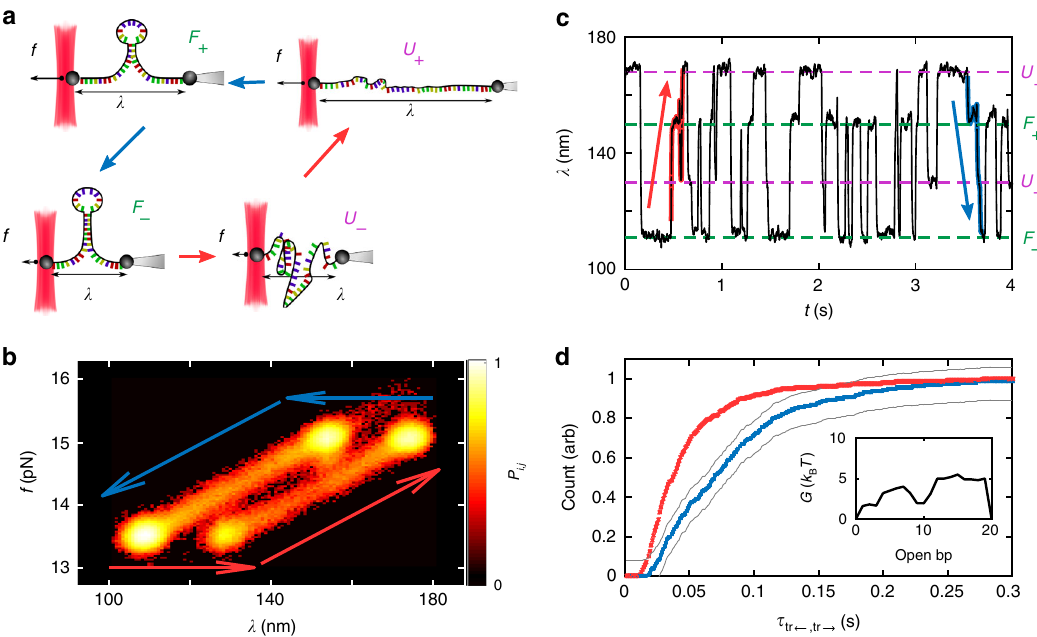
Fig. 5 Folding and unfolding transitions of DNA hairpins under fl uctuating external forces. a Sketch of the experiment: Each end of the DNA-hairpin strand is grafted onto a colloid. While one colloid is fi rmly attached to a pipette, the other is held in force-measuring optical tweezers. The position of the different states F + , F − , U + , U − are indicated in the λ × f plane (extension × force plane). b Relative occupation of states in the λ × f plane. c Excerpt of the dynamics of the hairpin. d Cumulative histogram of transition times from U + → F − (blue) and vice versa (red). The inset shows the free energy G of the barrier in equilibrium as a function of opened base